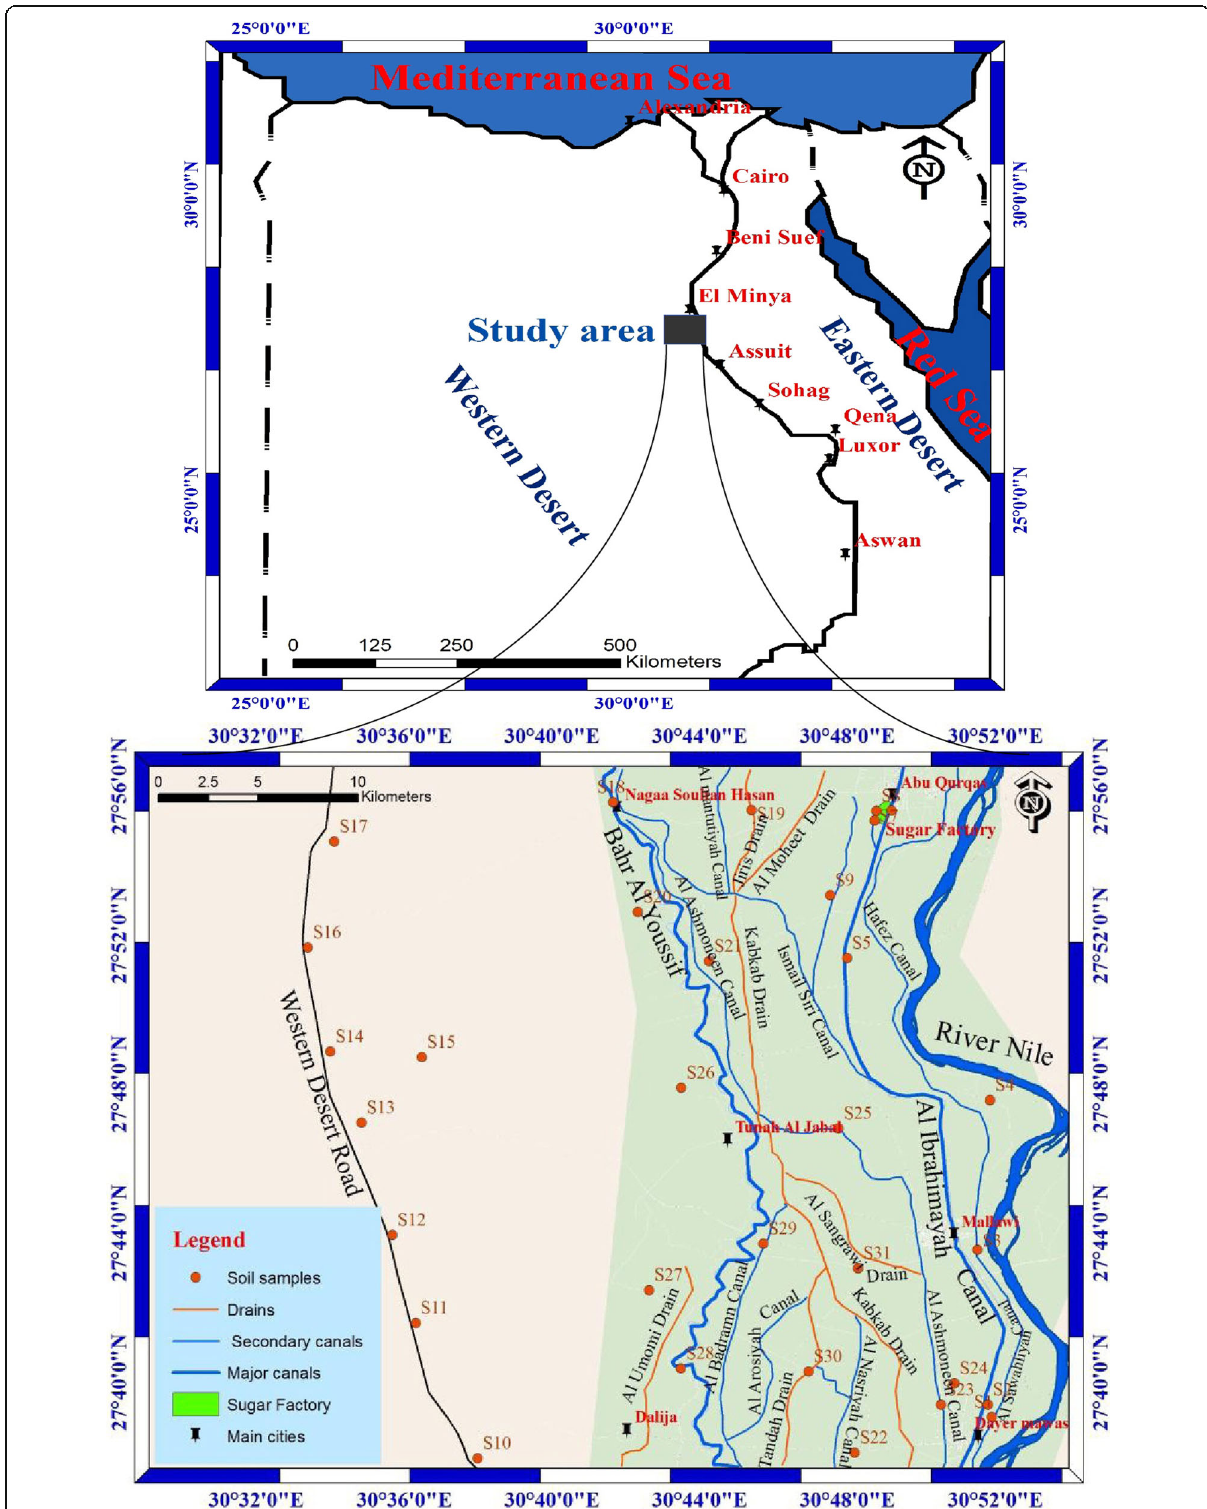
Fig. 1 Location map of the study area and sampling